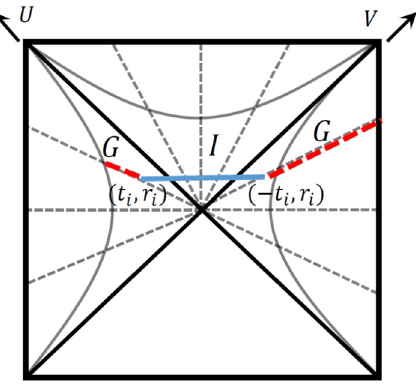
Fig. 7 An example of type 2 island I (thick blue line) and region G (think red dashed line). The left part of G is so narrow that its contri- bution to S mat ( G ) is